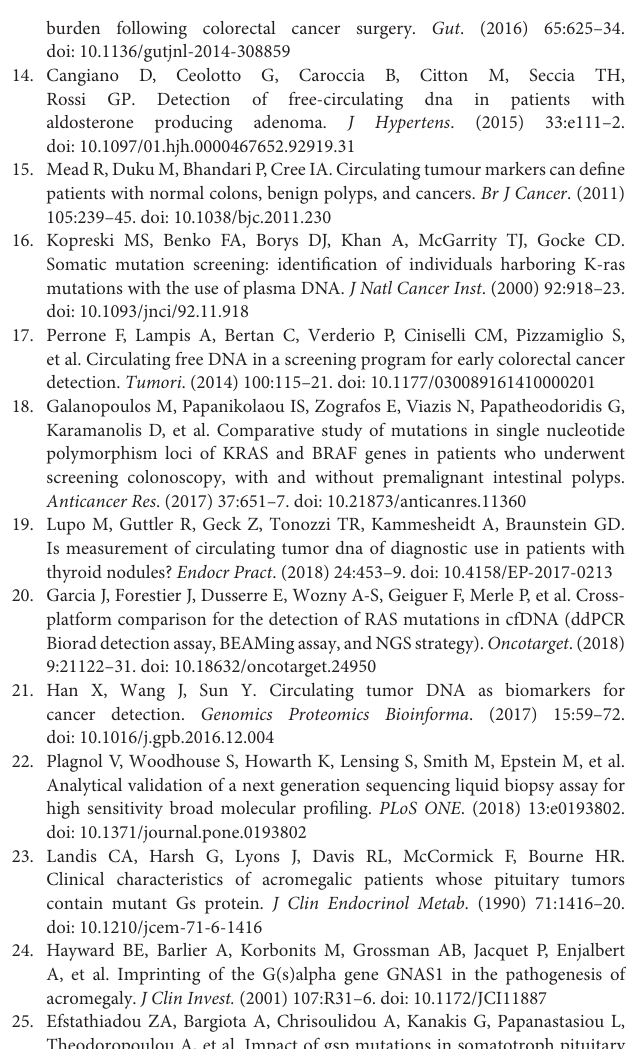
Supplementary Table 1 | Used primers (Metabion international AG,